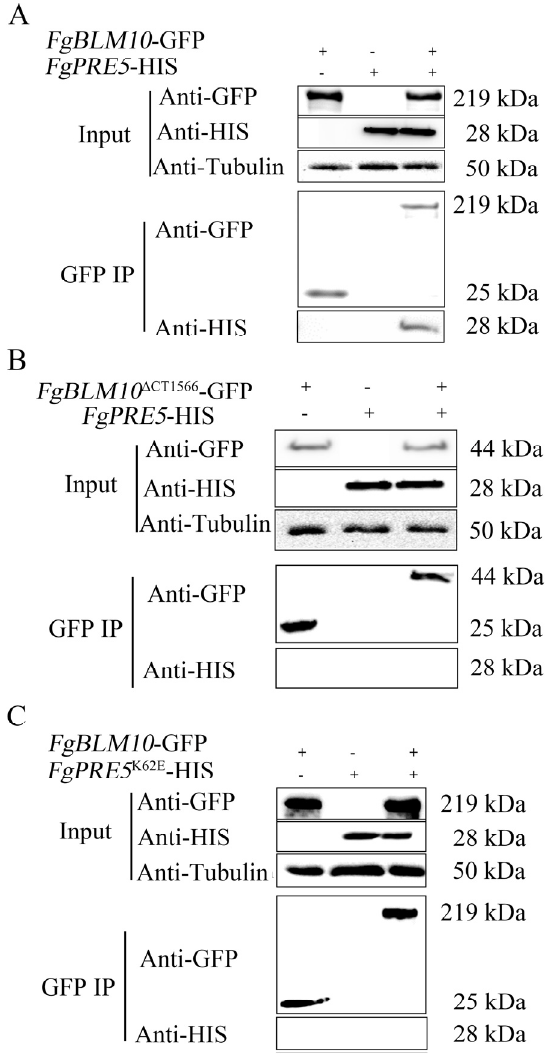
Figure 5. co-IP assays for the interaction of FgPre5 and FgPRE5 K52E with FgBlm10 and FgBlm10 ∆ CT1566 . ( A ) Western blots of total proteins (In for input) isolated from transformants expressing the FgPRE5 -His and FgBLM10 -GFP constructs and proteins immuno-precipitated (IP) with anti-GFP agarose beads were detected with the anti-GFP and anti-His antibodies. Detection with an anti- tubulin antibody was included as the negative co-IP control. ( B ) Western blots of total proteins and proteins immuno-precipitated with anti-GFP agarose beads of transformant expressing the FgPRE5 -His and FgBLM10 ∆ CT1566 -GFP constructs were detected with anti-GFP, anti-His antibod- ies, or anti- tubulin antibody. ( C ) Western blots of total proteins and proteins immuno-precipitated with anti-GFP agarose beads of transformant expressing the FgPRE5 K52E -His and FgBLM10 -GFP constructs were detected with anti-GFP, anti-His antibodies, or anti- tubulin